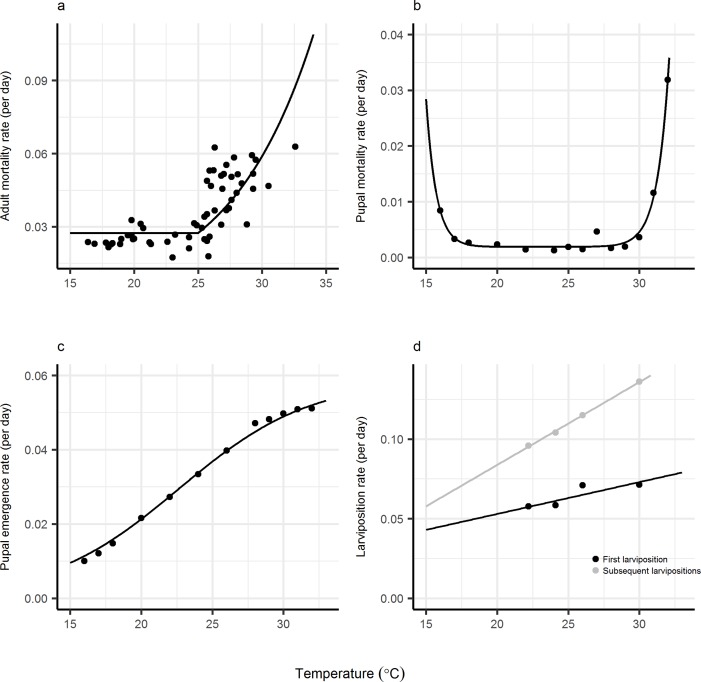
Fitted temperature-dependent functions.(a) Adult female mortality rate per day: points—published estimates from mark-recapture experiments on Antelope Island, Zimbabwe [30]; line—fitted temperature-dependent adult mortality function (Eq 1). (b) Pupal mortality rate per day: points—published estimates from laboratory experiments [27]; line—fitted temperature-dependent pupal mortality function (Eq 2). (c) Pupal emergence rate per day: points—published estimates from laboratory experiments; line—Eq 3 fitted as described in [26]. (d) Larviposition rate per day: points—data from published field experiments [28]; lines—Eq 4 fitted as described in [30]. See Table 1 for fitted parameter estimates of the mortality functions.